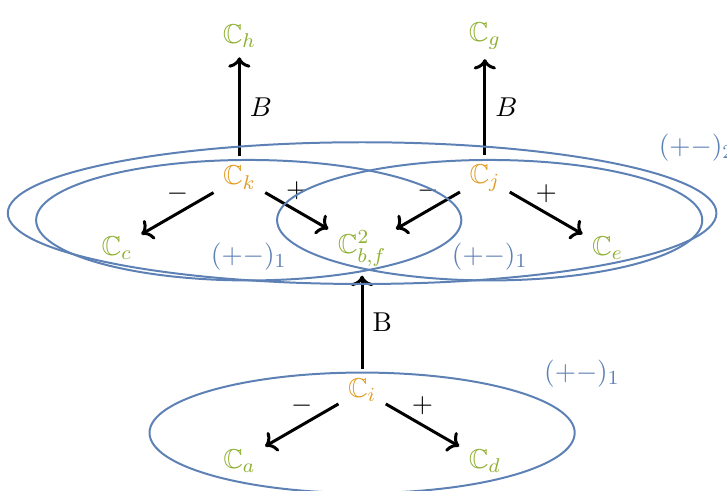
Figure 42. Covering quiver for the dimension (3 ; 8)